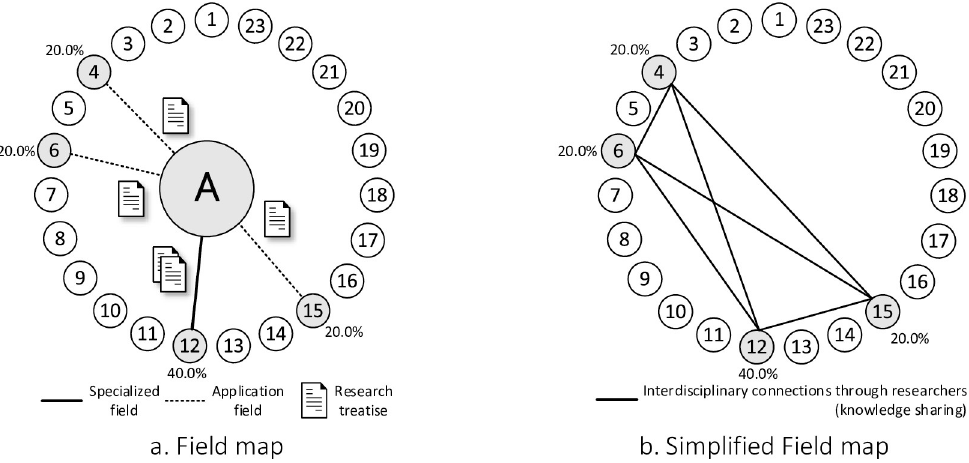
Fig 2. Examples of researcher A’s areas of expertise and their